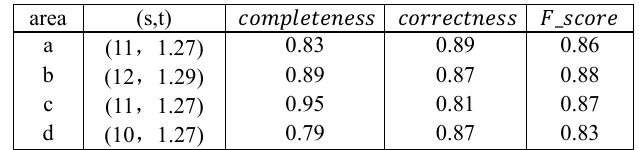
Table 1. Evaluation of extracted marking of